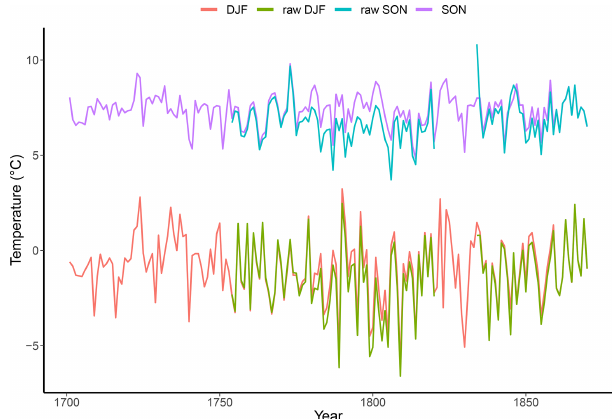
Figure 8. Raw and homogenized seasonal DJF and SON mean temperatures at Lund, 1701–1870. Sources: Copenhagen (Cappe- len et al., 2019), Berlin–Dahlem (DWD, 2018), De Bilt (Durre et al., 2008; Lawrimore et al., 2011), Lund (Tidblom, 1876), Upp- sala (Bergström and Moberg, 2002), and Stockholm (Moberg et al., 2002; Moberg, 2021). Note: see Appendix A for a further dis- cussion of the homogenization